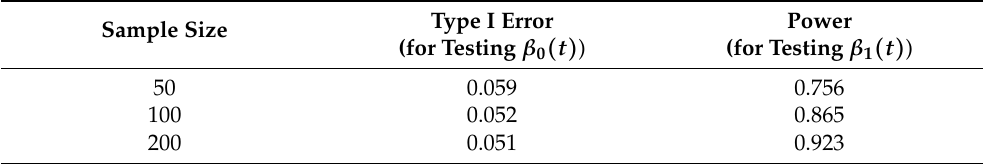
Table 1. Summary of simulation results for linearity testing.